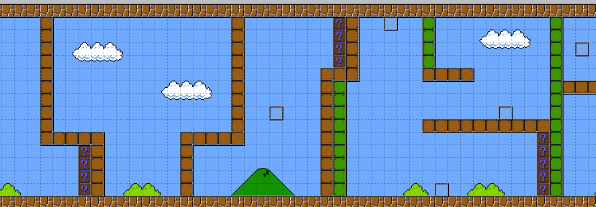
Figure 8. Beginning of level 3 introduces a new mechanic and a gradual increase in difficulty. Transparent blocks are rendered as